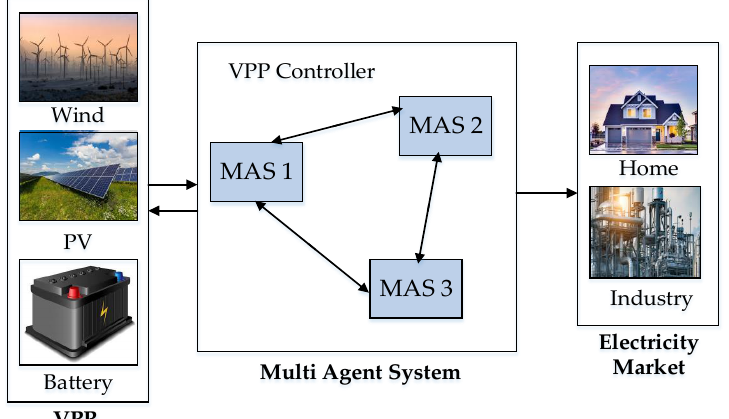
Figure 13. A multi-agent system-based co-ordination between the virtual power plant and electricity